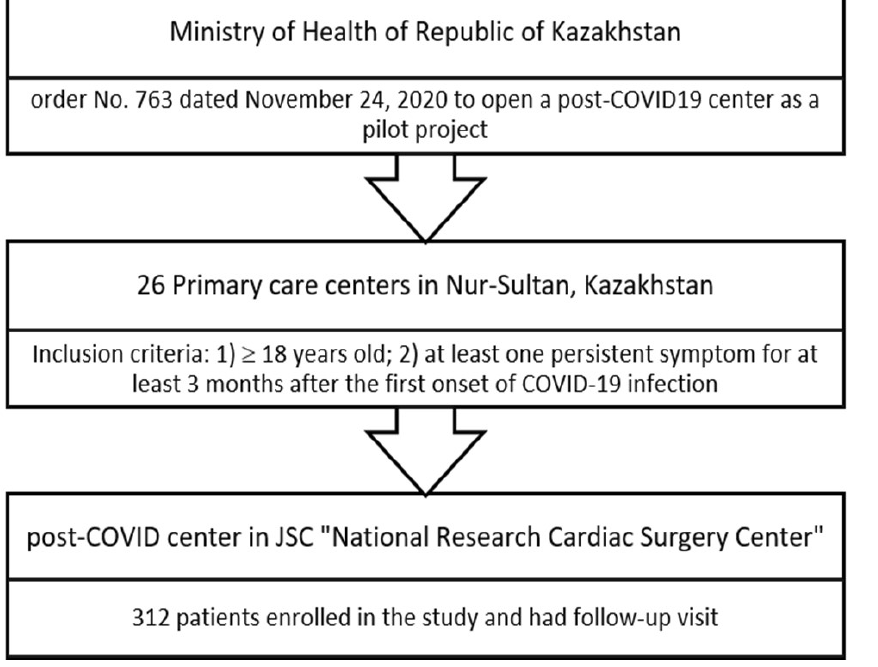
Figure 1. Study flow diagram.